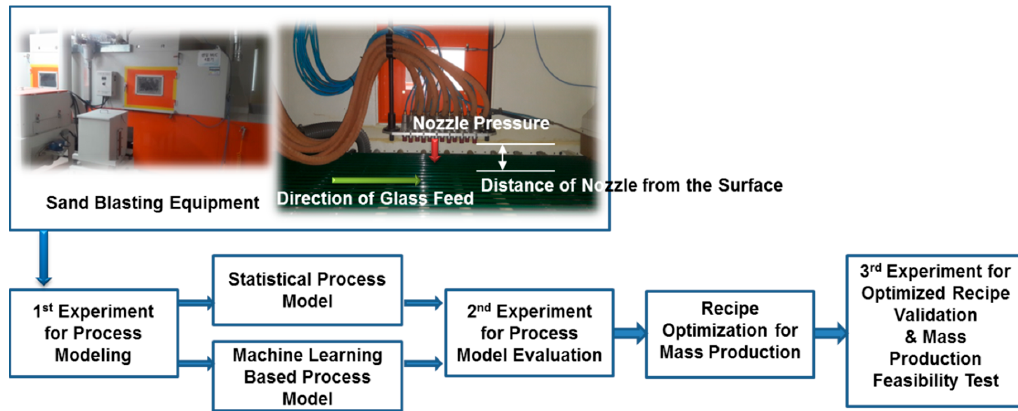
Figure 1. The flow of the proposed method for modeling and recipe generation of the sandblasting process for anti-glare (AG) surface treatment.